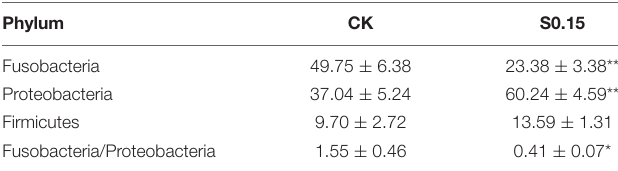
TABLE 2 | The predominant gut bacterial phylum in zebrafish fed the CK or S0.15 for 4 weeks based on V3–V4 sequences. Phylum CK S0.15